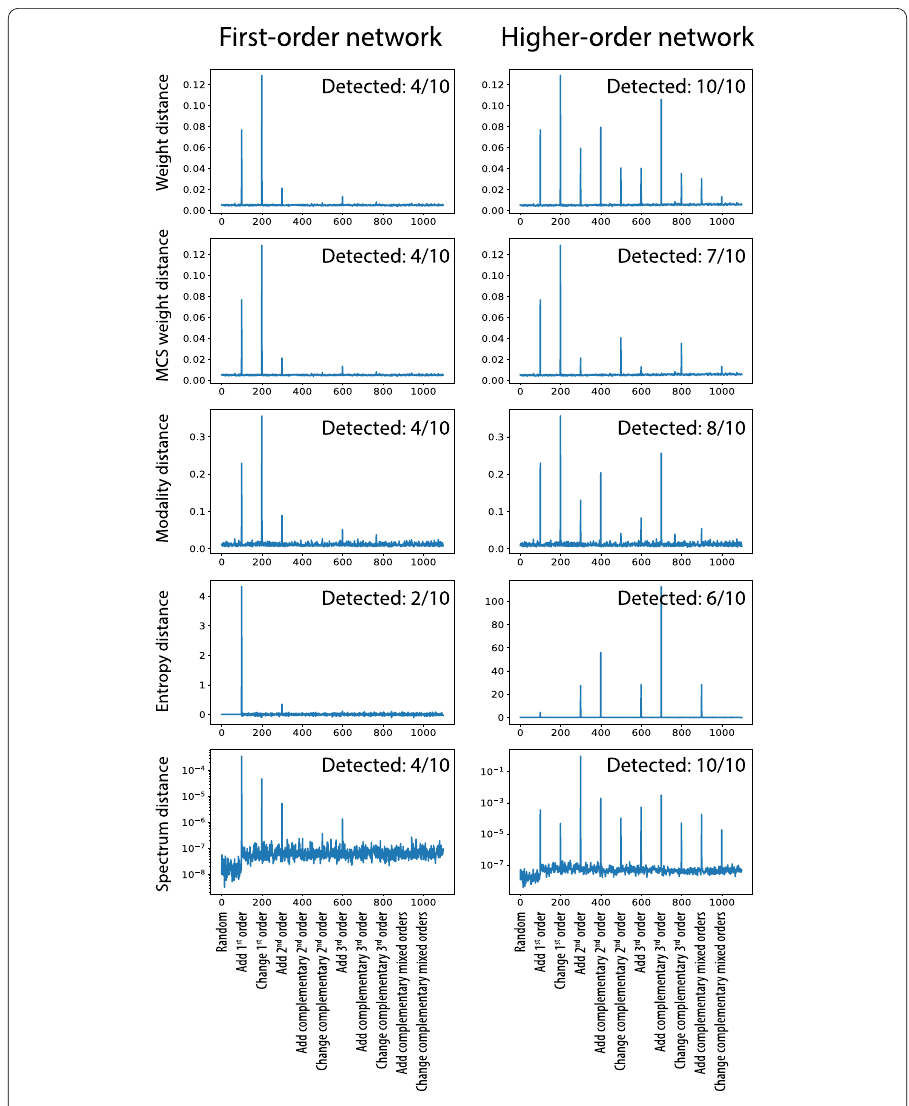
Figure 7 Methods that use FON collectively fail to capture anomalous navigation behaviors beyond first-order no matter what distance metric is used, but all show signals when HON is used instead